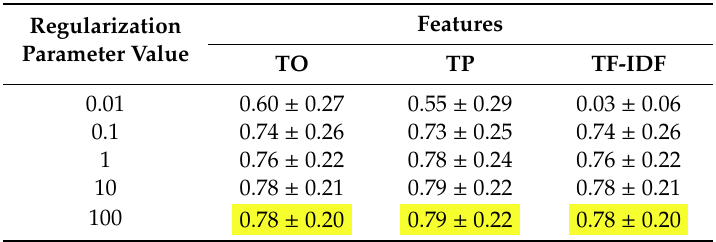
Table 2. Result of parameter tuning for logistic regression.